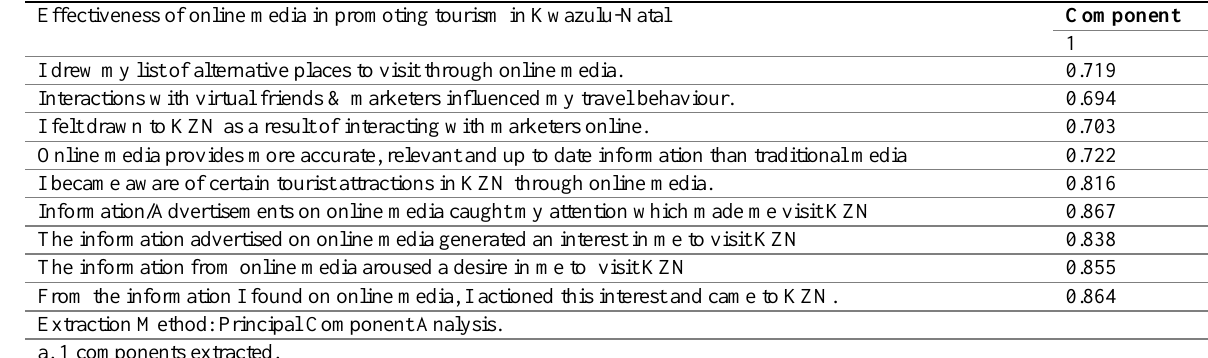
Table 4: Component Matrix; Effectiveness on online media